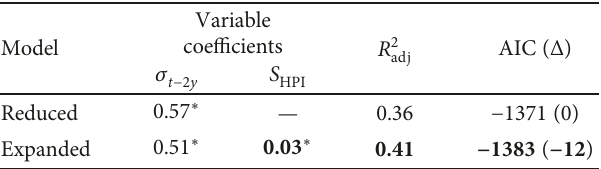
Figure 10: The cross-correlation function between the volatility of t estimated for the U.S. HPI index σ t and the SCC index S HPI the house price dataset. The observed cross-correlation function peaks around τ = 5 quarters and remains relatively high between τ = 2 and τ = 8 . Table 2: Regression analysis of the developed SCC index on the future realized market volatility, using reduced (without the SCC index S ) and expanded (including S ) models, performed on the U.S. house price data. Coe ffi cients signi fi cant at the 1% signi fi cance level are marked with an asterisk ( ∗ ). The respective adjusted R 2 measures and the Akaike information criterion (AIC) are also reported — including the AIC di ff erence ( Δ ) from the null (reduced)